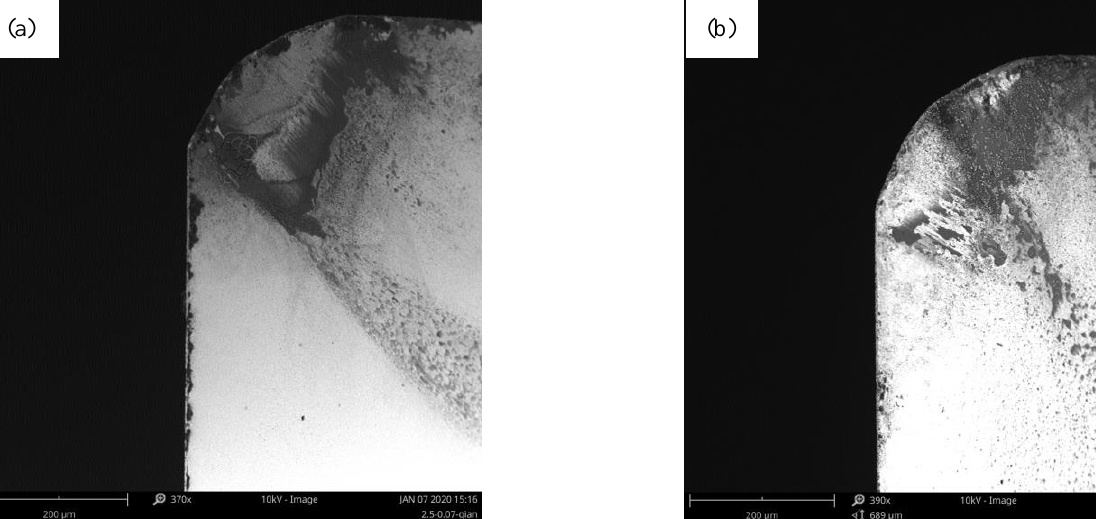
Figure 16. The wear morphology of rake face at 0.07 mm/rev when the milling length reached ( a ) 2.5 m; ( b )7.5 m.